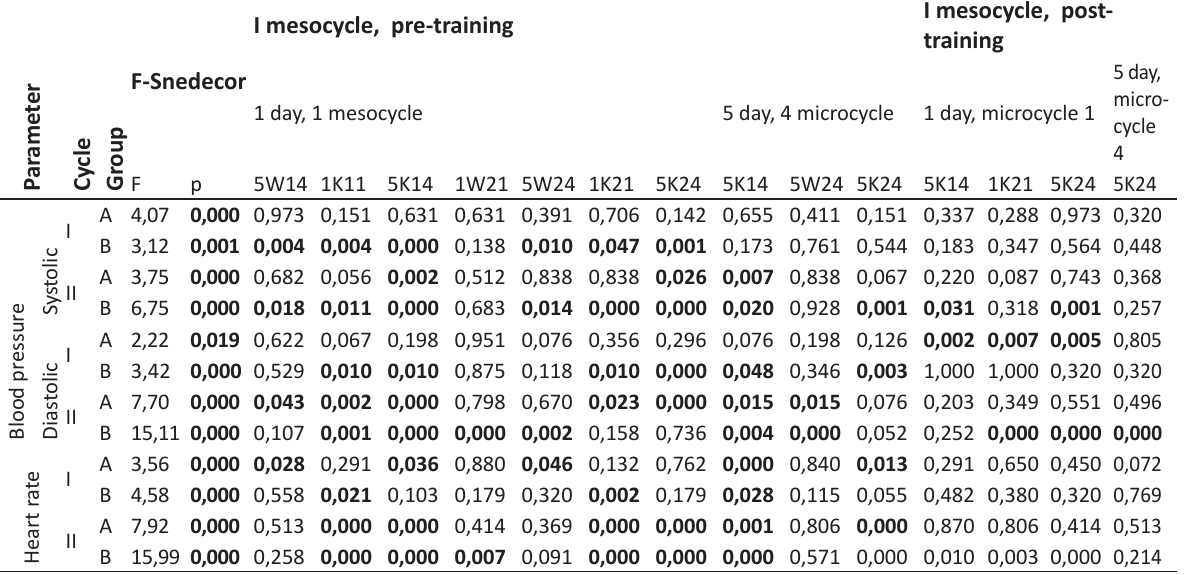
- marked in bold; LSD - least significant difference; symbols indicating the day of the study are designed as follows (e.g. 5W14): first number indicates micro-cycle day, second capital letter indicates type of measurement (W-pre-training; K-post-training); third number indicates mesocycle (1-first; 2-second); fourth number indicates microcycle number (from 1 to